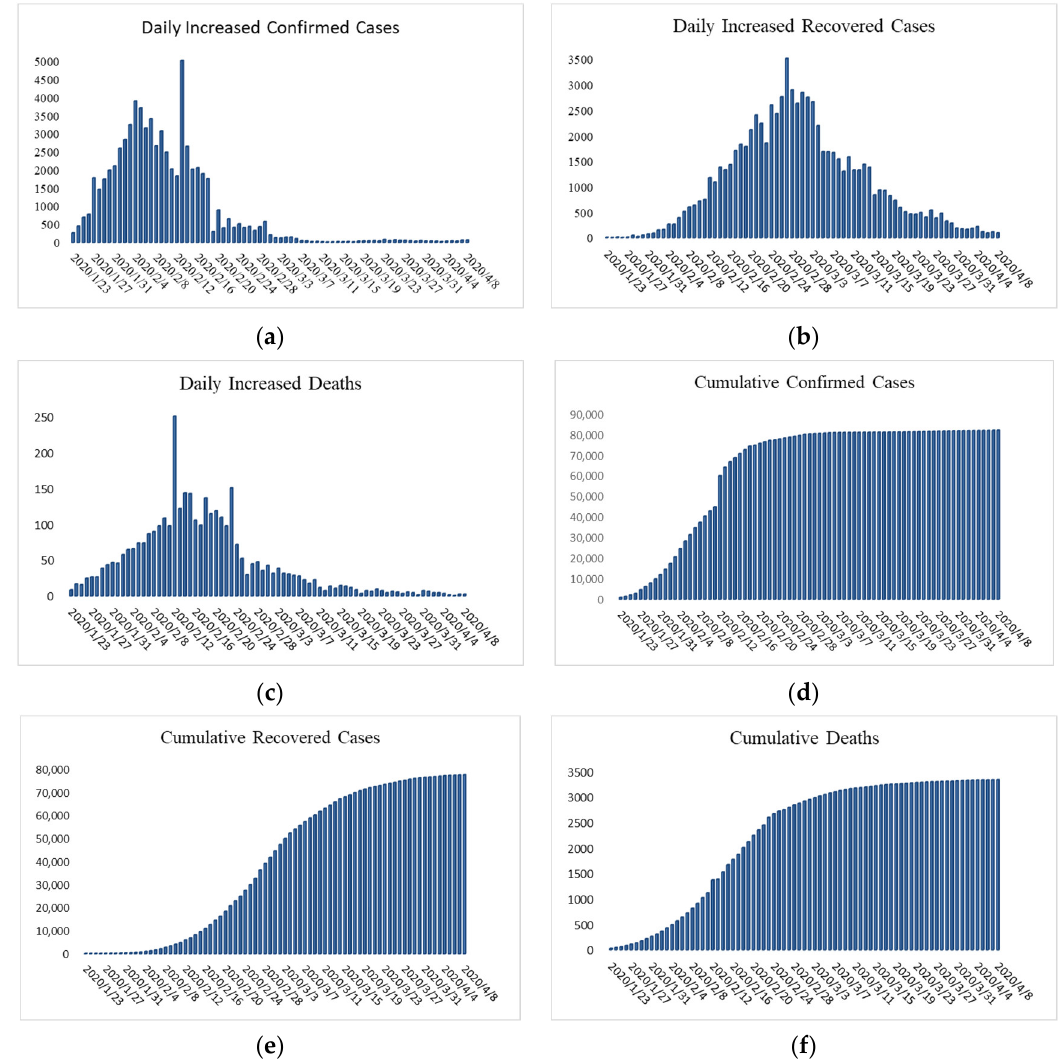
Figure 5. Number of daily increased and cumulative cases for confirmed cases, recovered cases, and deaths. ( a ) Daily increased confirmed cases; ( b ) daily increased recovered cases; ( c ) daily increased deaths; ( d ) cumulative confirmed cases; ( e ) cumulative recovered cases; ( f ) cumulative deaths.